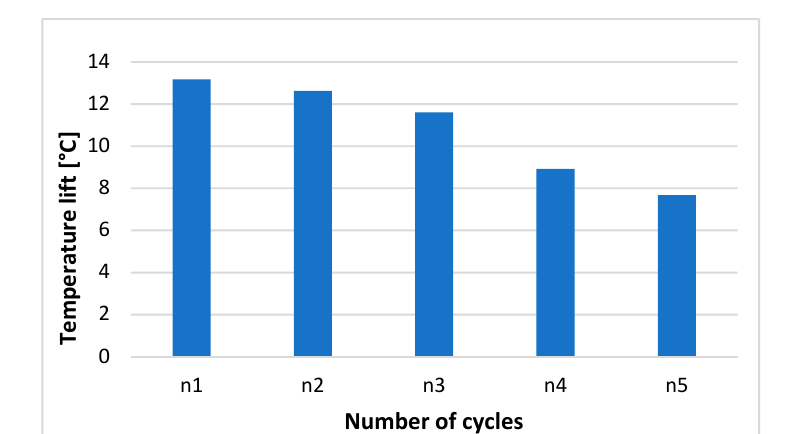
Figure 6. Output temperatures for all cycles.